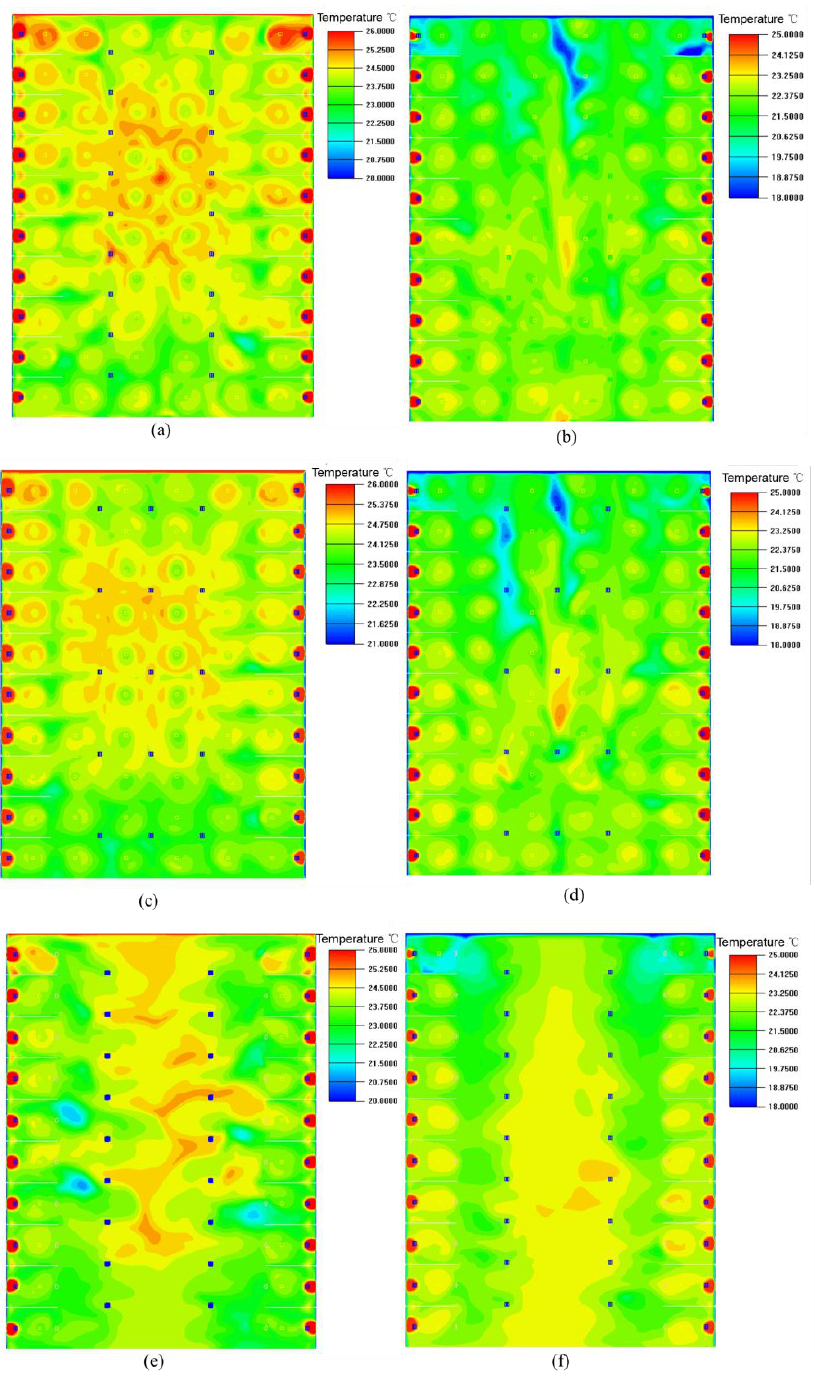
Figure 10. Temperature distribution at Y = 1.5 m: Scheme 1 in summer ( a ), and 1 in winter ( b ); Scheme 2 in summer ( c ), and in winter ( d ); Scheme 3 in summer ( e ), and in winter ( f ).